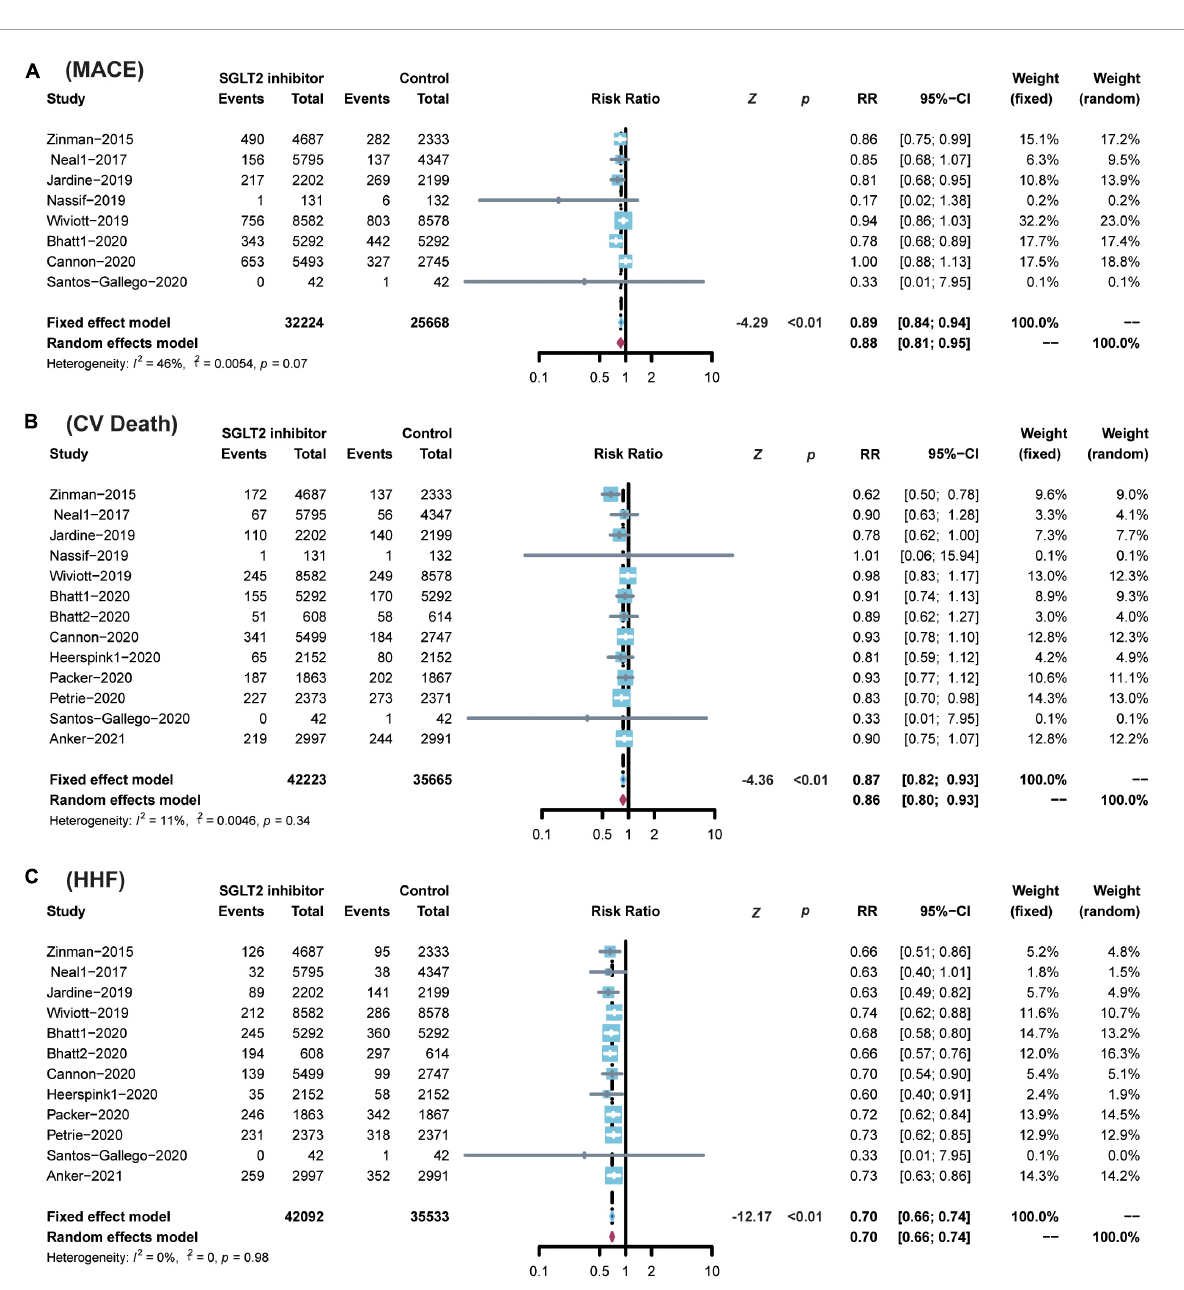
CI: 0.99–1.12; p for heterogeneity 0.24; I 2 = 27%; p =